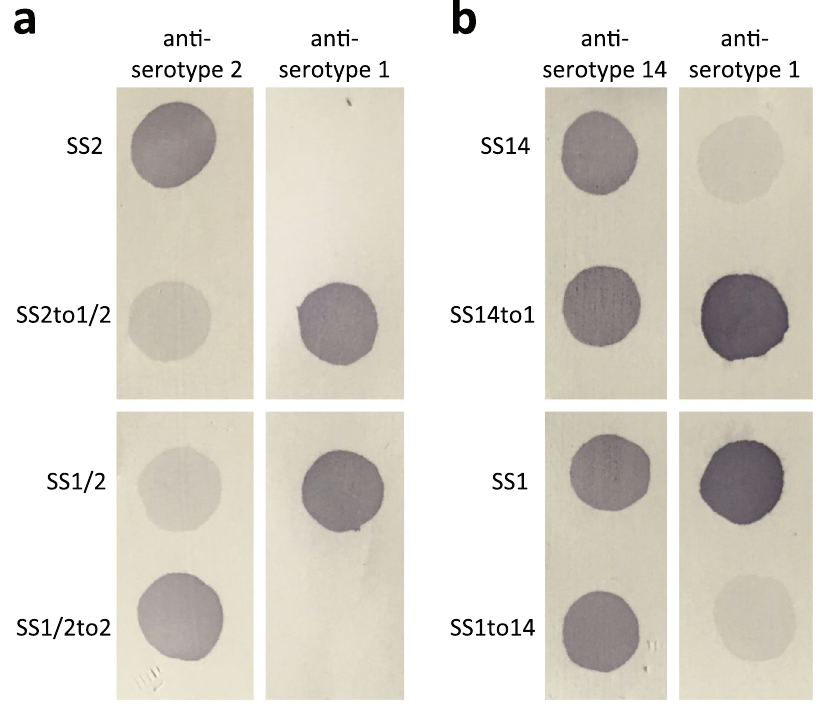
Figure 2. Serotype switching of mutants is confirmed by dot blotting of purified CPS preparations and specific antisera. ( a ) The CPS from a serotype 2 field strain reacts with anti-serotype 2 but not with anti-serotype 1 sera, while the CPS from mutant strain SS2to1/2 (W161C) reacts with both antisera (top panel). The CPS from a serotype 1/2 field strain reacts with both anti-serotype 1 and anti-serotype 2 sera, while the CPS from mutant strain SS1/2to2 (C161W) reacts with anti-serotype 2 but not with anti-serotype 1 sera (bottom panel). ( b ) The CPS from a serotype 14 field strain reacts strongly with anti-serotype 14 and weakly with anti-serotype 1 sera, while the CPS from mutant strain SS14to1 (W161C) reacts strongly with both antisera (top panel). The CPS from a serotype 1 field strain reacts strongly with both anti-serotype 14 and anti-serotype 1 sera, while the CPS from mutant strain SS1to14 (C161W) reacts strongly with anti-serotype 14 but weakly with anti-serotype 1 sera (bottom